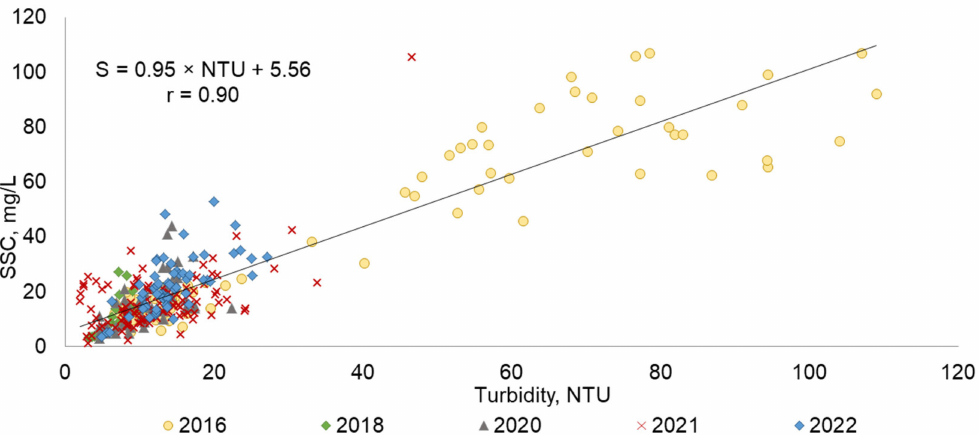
Figure 4. The SSC = f(T) relationship for the middle and low courses of the Lena River. 2016-model: 82 measurements from 20 to 29 June and from 8 to 10 July 2016 (Lena River Yakutsk anabranching system). 2020-model: 58 measurements from 25 June to 10 July (Lena River from Pokrovsk to Saham anabranching system). 2021-models: 106 measurements 2 expeditions: from 3 to 5 July (Saham branching system) and from September 23 to September 25 (Yakutsk anabranching system). 2022-model: 38 measurements from 10 to 19 June (Lena River Yakutsk anabranching system) and 22 measurements from 10 to 16 August (Lena River delta).